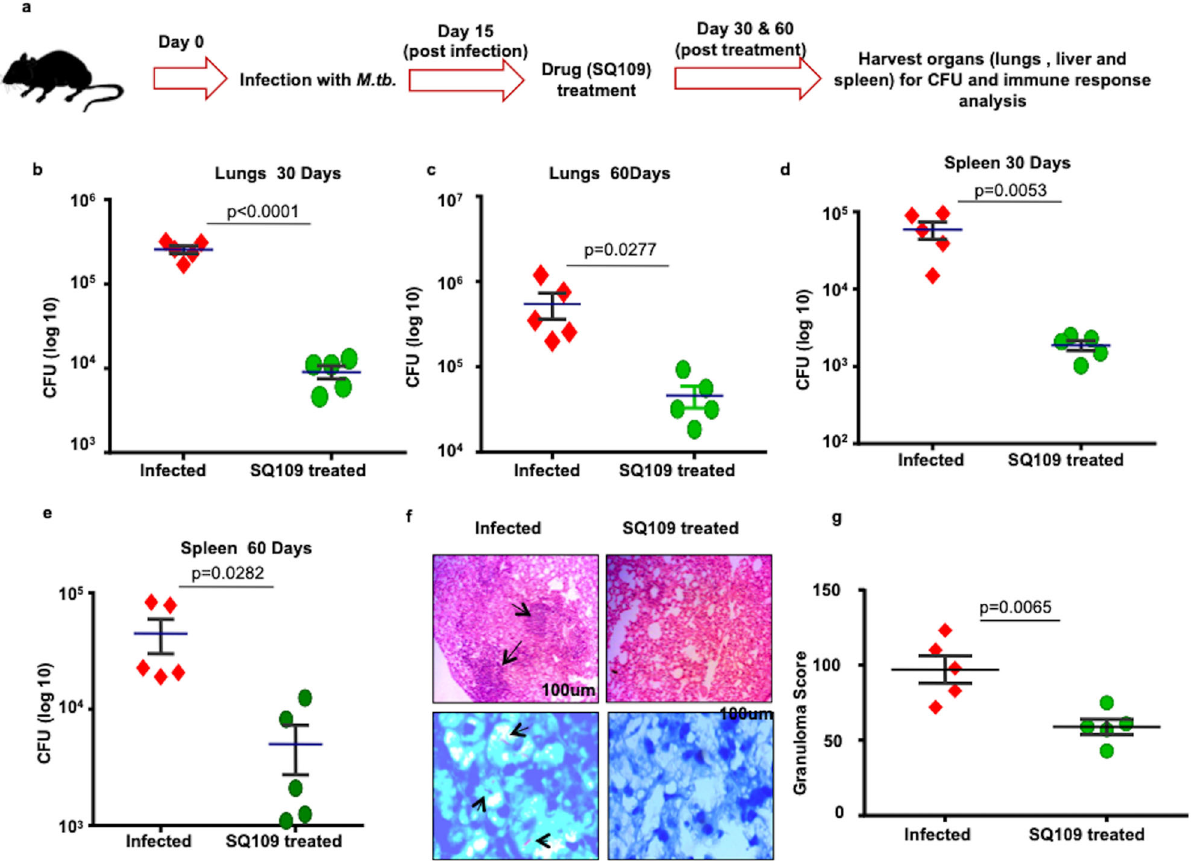
Fig. 1 SQ109 treatment reduces the bacterial burden in a murine model of tuberculosis. a Schematic diagram to show different groups of C57BL/6 mice challenged with H37Rv strains of M.tb via the aerosol route with a low-dose inoculum of ~110 CFU/mouse. After 15 days groups of mice were treated daily with SQ109 (10 mg/kg) for 30 or 60 days. Mice were sacri fi ced and lungs and spleen were harvested for estimation of bacterial burden and analysis of immune responses. b , c CFU from lung homogenates at 30 and 60 days post-treatment. d , e CFU from spleen homogenates at 30 and 60 days post- treatment. f Lungs from the different groups of mice were harvested, preserved in 4% paraformaldehyde, sectioned and stained with Hematoxylin and Eosin (H&E) and AFB. (Arrows indicate granulomatic lesions and bacilli in infected mice). g Bar diagram to show the number of granulomas in infected and treated mice. n = 5 biological replicates were used for two independent experiments. Statistical signi fi cance was determined using unpaired t